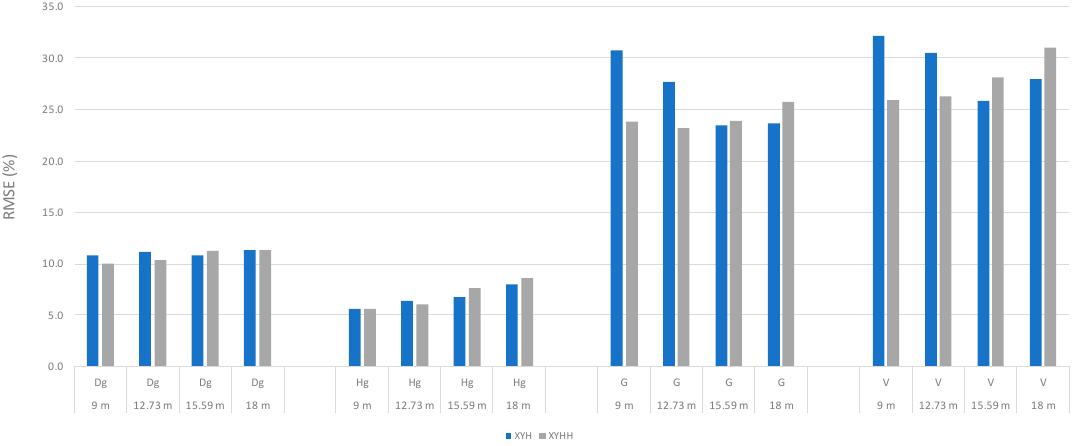
Figure 3. Root-mean-square errors (RMSEs) of the stand level ( n = 150) predictions for D g , H g , G, and V. Predictions were made using two different single-tree positioning methods for deriving forest inventory attributes for sample plots (XY H , XY HH ) and with four different sample plot sizes. Note that sample plot size is given as the radius (in m) of the sample plot, not the area (in m 2 ). See also data from Table 2.